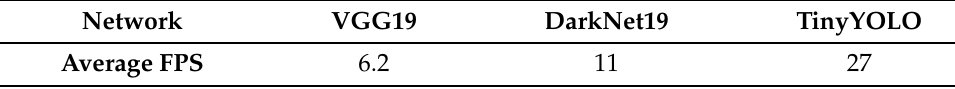
Figure 28. Recall–precision curve for VGG19, DarkNet, and TinyYOLO networks trained for 4 epochs. IoU threshold = 0.5. Table 3. Comparing the average FPS of the trained